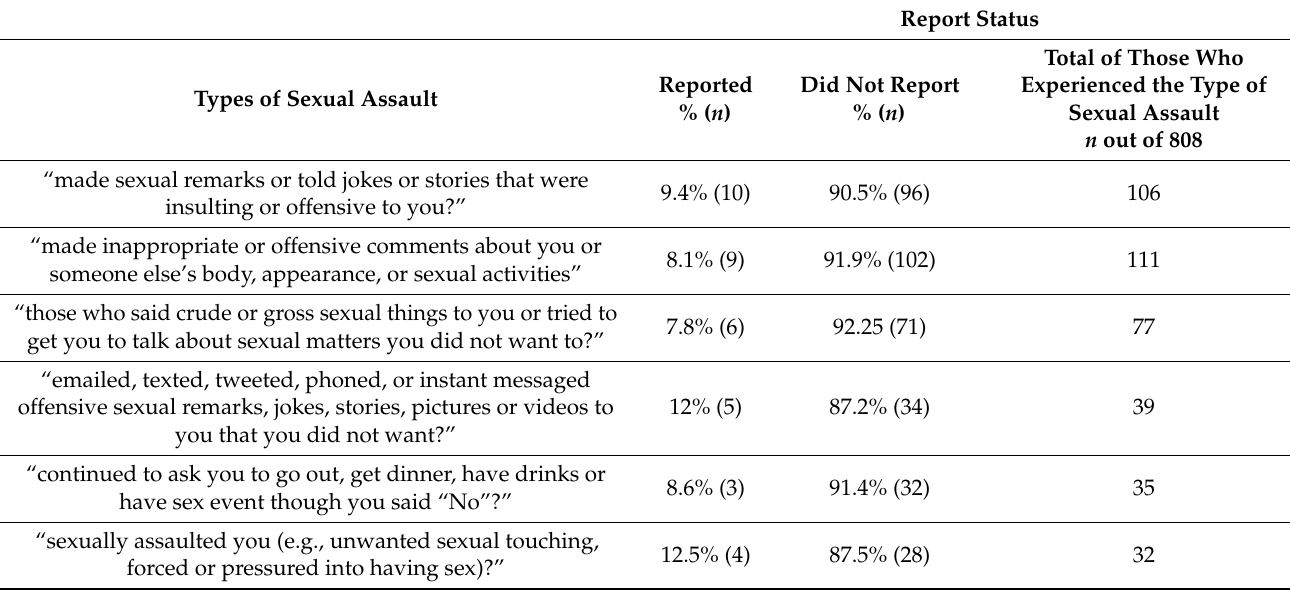
Table 6. Different Types of Sexual Assaults and Rates of Reporting.